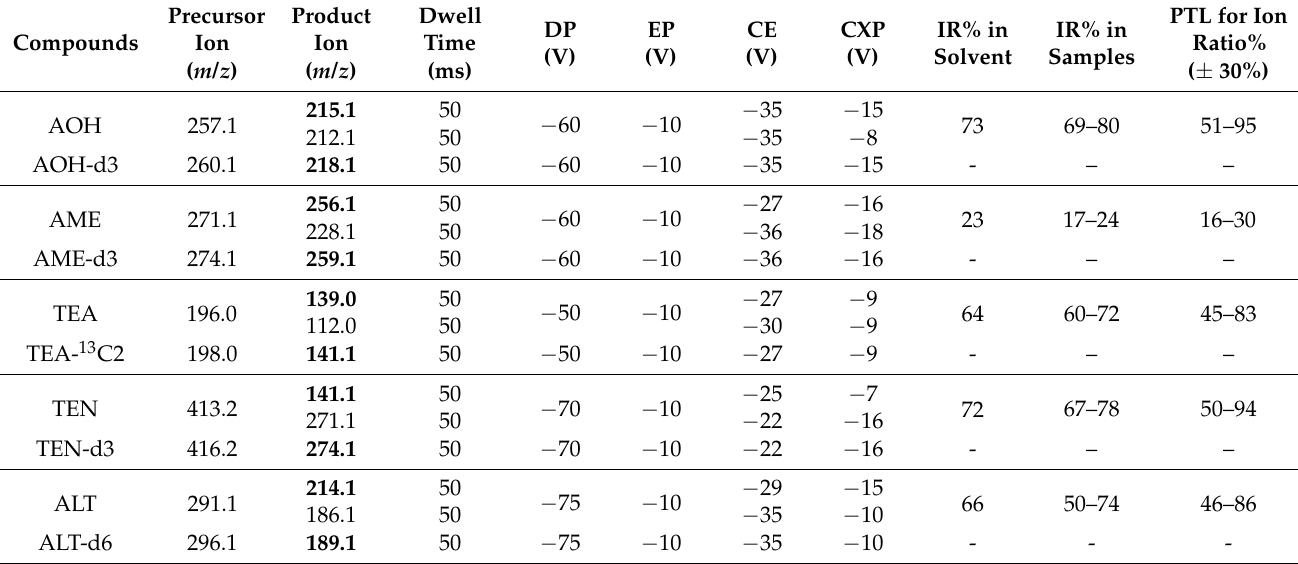
Table 1. Tandem mass spectrometric (MS/MS) detection parameters for Alternaria toxins optimized for AB Sciex 6500+ QTRAP instrument equipped with IonDrive Turbo V